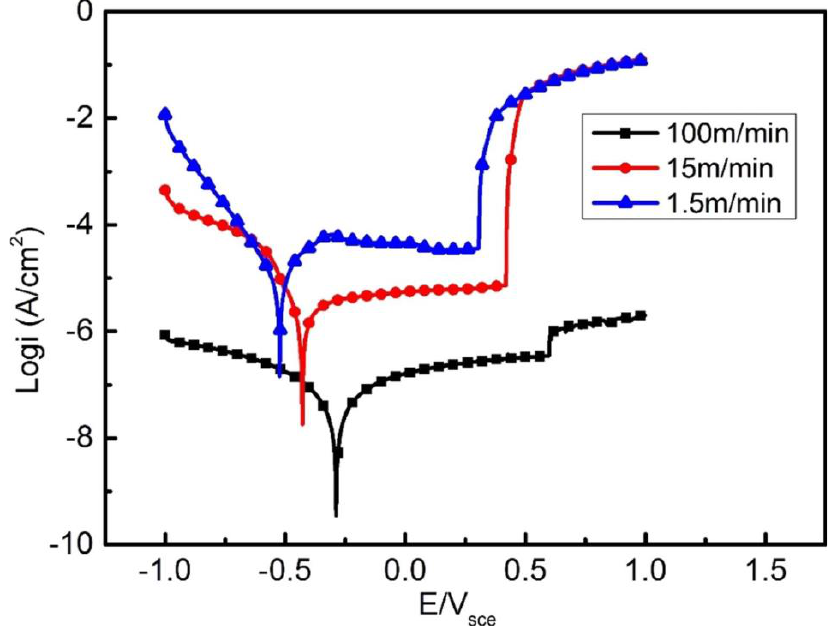
Figure 13. Potentiodynamic polarization curves during cladding of AISI 431 grades (martensitic stainless steel) onto 27SiMn steel specimens corresponding to three laser scanning speeds. Reproduced with permission from [49]. Copyright Elsevier, 2020.